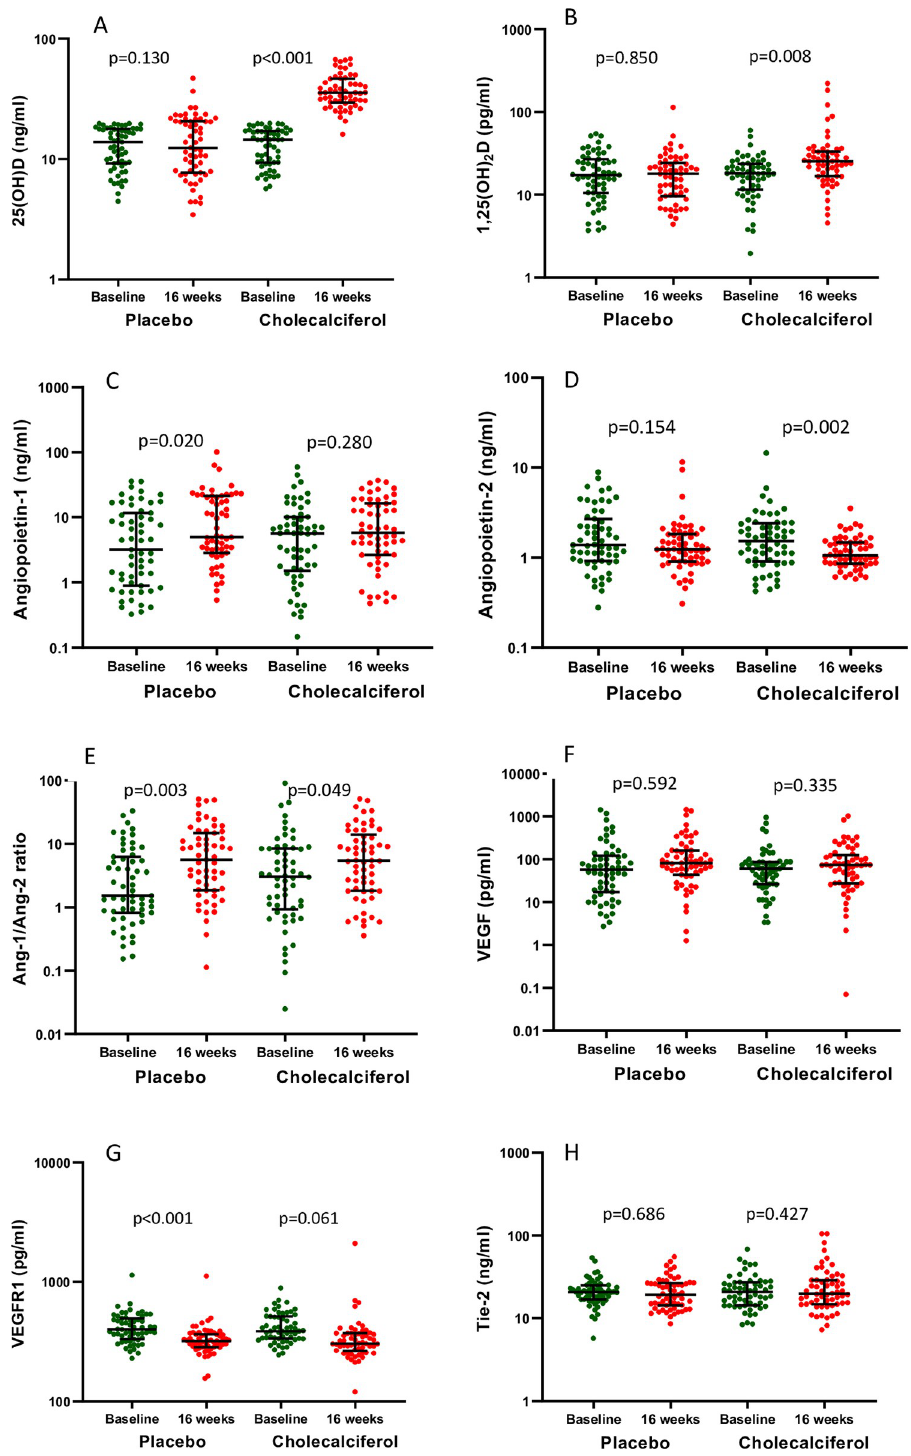
Fig 2. Represents the levels of biomarkers as baseline and follow up in placebo and cholecalciferol group. A. 25 (OH) vitamin D, B. 1,25 (OH) 2 vitamin D, C. Angiopoietin -1, D. Angiopoietin -2, E. Angiopoietin-1/ Angiopoietin-2 ratio, F. VEGF, G. VEGFR, and H.